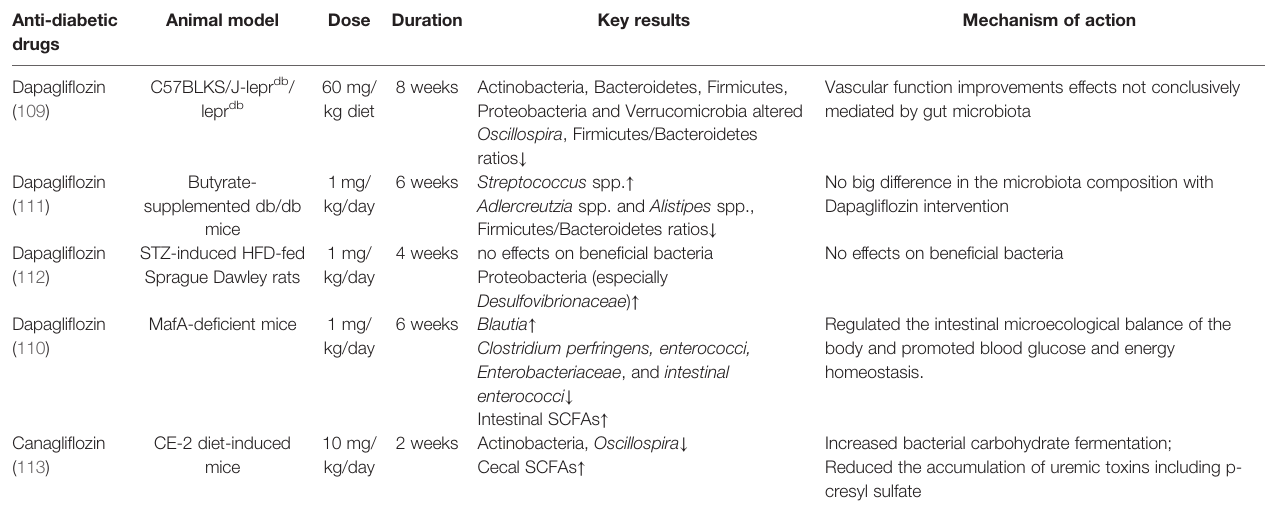
TABLE 2 | Experimental animal studies analyzing the effects of SGLT2 inhibitors on gut